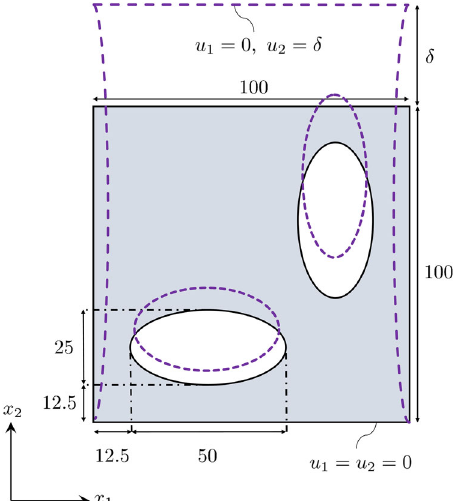
Fig. 2 Geometry and boundary conditions of the chosen domain: a plate with two elliptic holes under displacement-controlled vertical tension followed by vertical compression. All dimensions are in